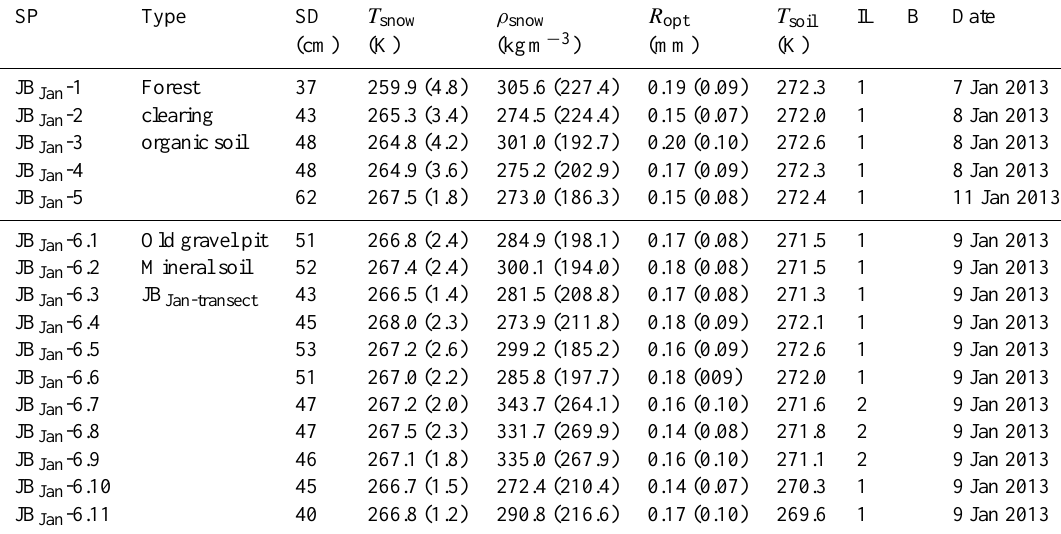
Table 1. Average snow property values with standard deviation (in parentheses) at James Bay (JB) sites in January. Values are provided for snow depth (SDm), mean snowpack temperature ( T snow ) , bulk density ( ρ snow ) , mean optical radius ( R opt ) , soil/snow temperature ( T soil ) and number of observed ice lenses (ILs); SP is snow pit and “bridging” (B) indicates the presence of a snow layer with a density within the bridging ice fraction limits (see Sect.